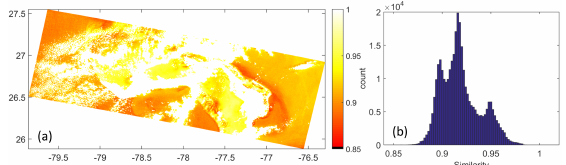
Figure 11. Similarity between the estimates of the remote sensing reflectance spectra from the proposed algorithm and the level 2 MERIS data of the same day and time—( a ) similarity map ( b ) histogram of the similarity